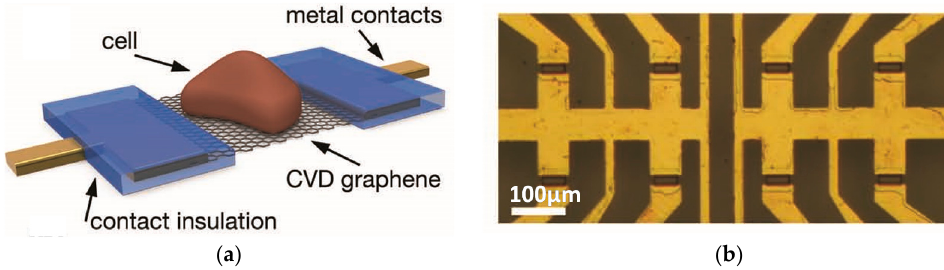
Figure 13. ( a ) Schematic view of a G-SGFET with a cell on the gate area; ( b ) Optical microscopy image showing eight transistors in the central area of a G-SGFET array. ( a , b ) Reproduced with permission from [140], Wiley, copyright 2011.